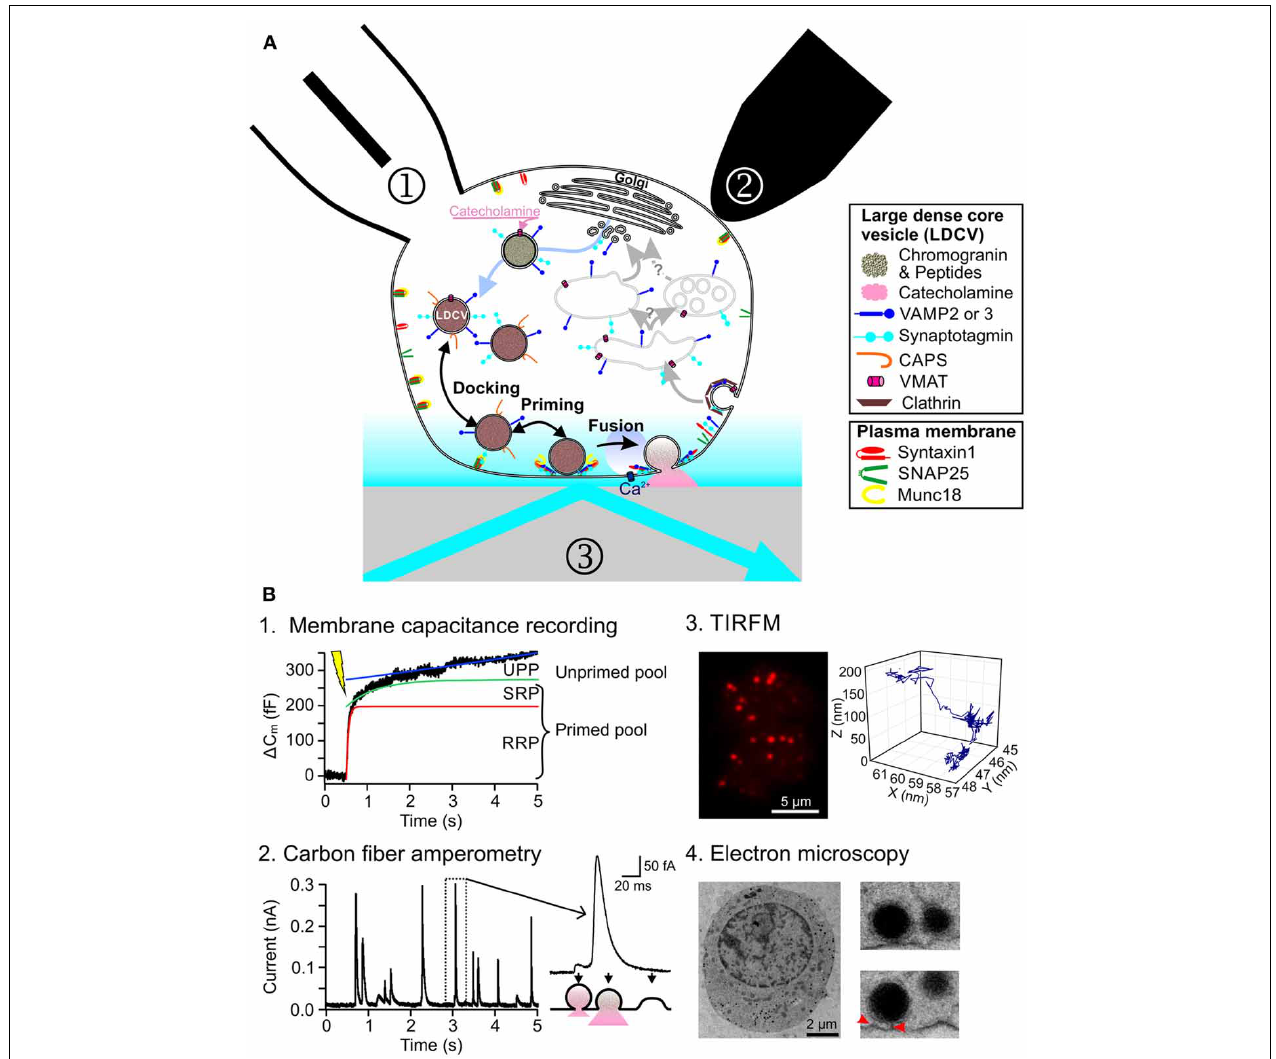
FIGURE 1 | Current methods to study regulated exocytosis in chromaffin cells. (A) Model of regulated exocytosis in chromaffin cells depicting a number of proteins involved in the process. Exocytosis of LDCVs can be monitored by ① membrane capacitance through patch clamp electrophysiology, ② carbon fiber amperometry and ③ TIRFM. (B) Example of exocytosis measurement in chromaffin cells. (B1) Representative trace of a membrane capacitance recording in which exocytosis was induced by flash photolysis of caged Ca 2 + . Three functional pools can be determined by fitting the data with 3 components: a fast exponential (RRP, red line), a slow exponential (SRP, green line) and a linear regression (UPP, blue line).